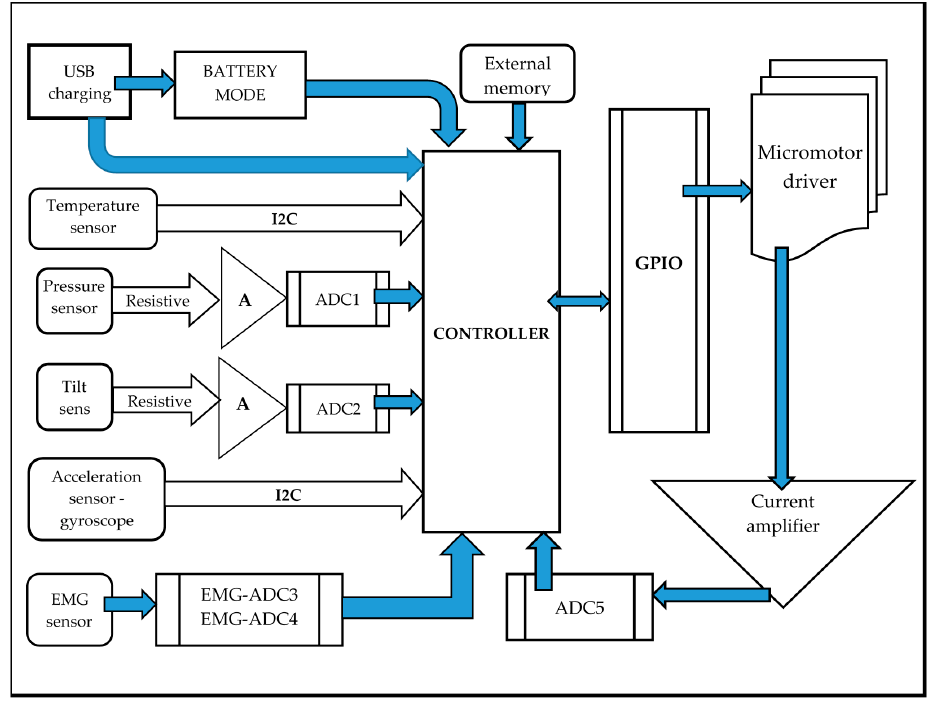
Figure 7. The block scheme for the designed prosthesis.